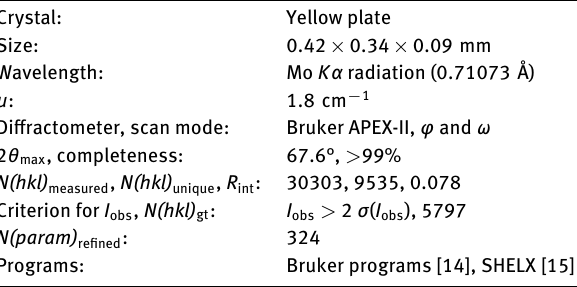
Table 1: Data collection and handling.